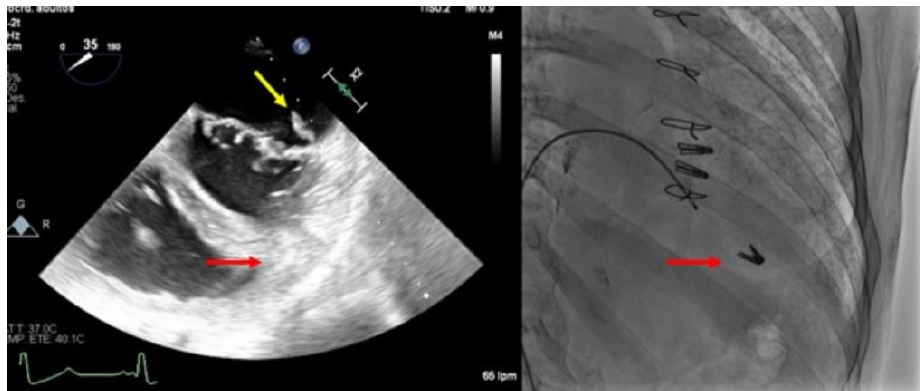
Figure 6. Clip embolization. ( Left ) Two-dimensional transesophageal echocardiogram showing a posterior leaflet prolapse (yellow arrow) after retrograde embolization of a clip to the right ventricle through the procedural atrial septal defect (red arrow). ( Right ) Fluoroscopy image at the end of the procedure showing two clips implanted in the mitral valve and another one embolized in the apex of the right ventricle (red arrow).